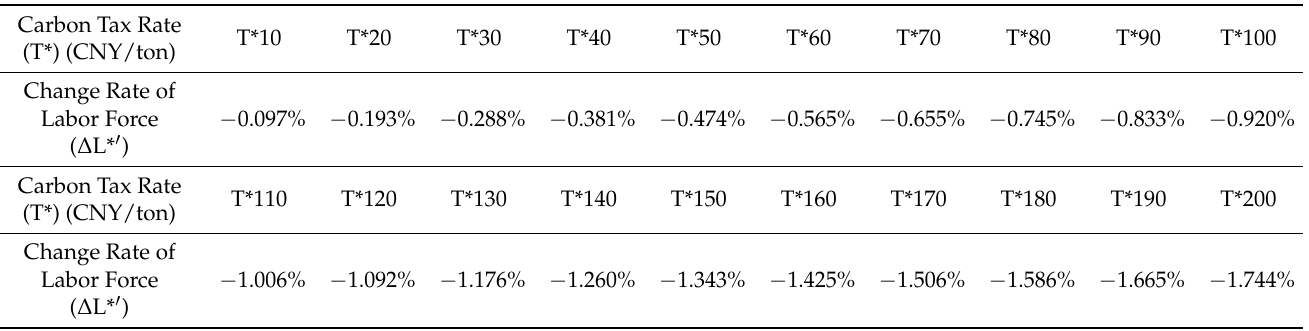
Table 4. Relationship between carbon tax and total labor force.